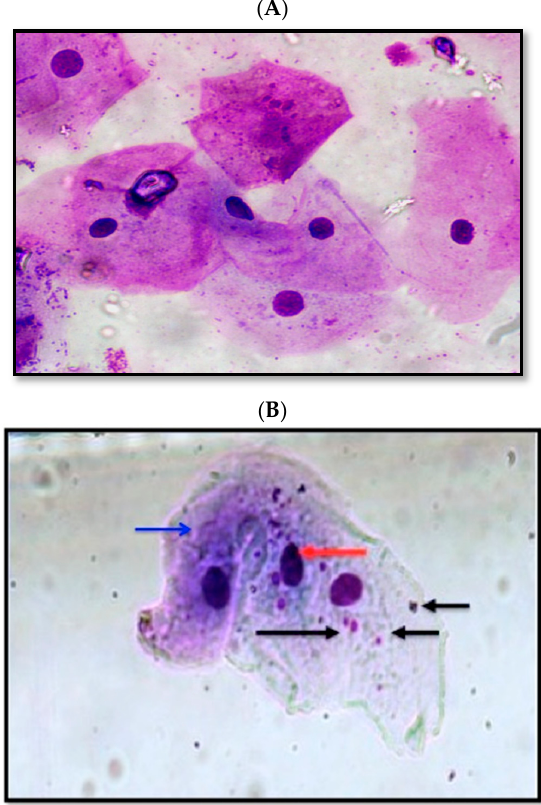
Table 3. Correlation between age and TNF- α levels.